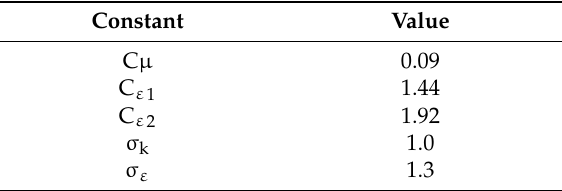
Table 1. The K-ˆ ε model